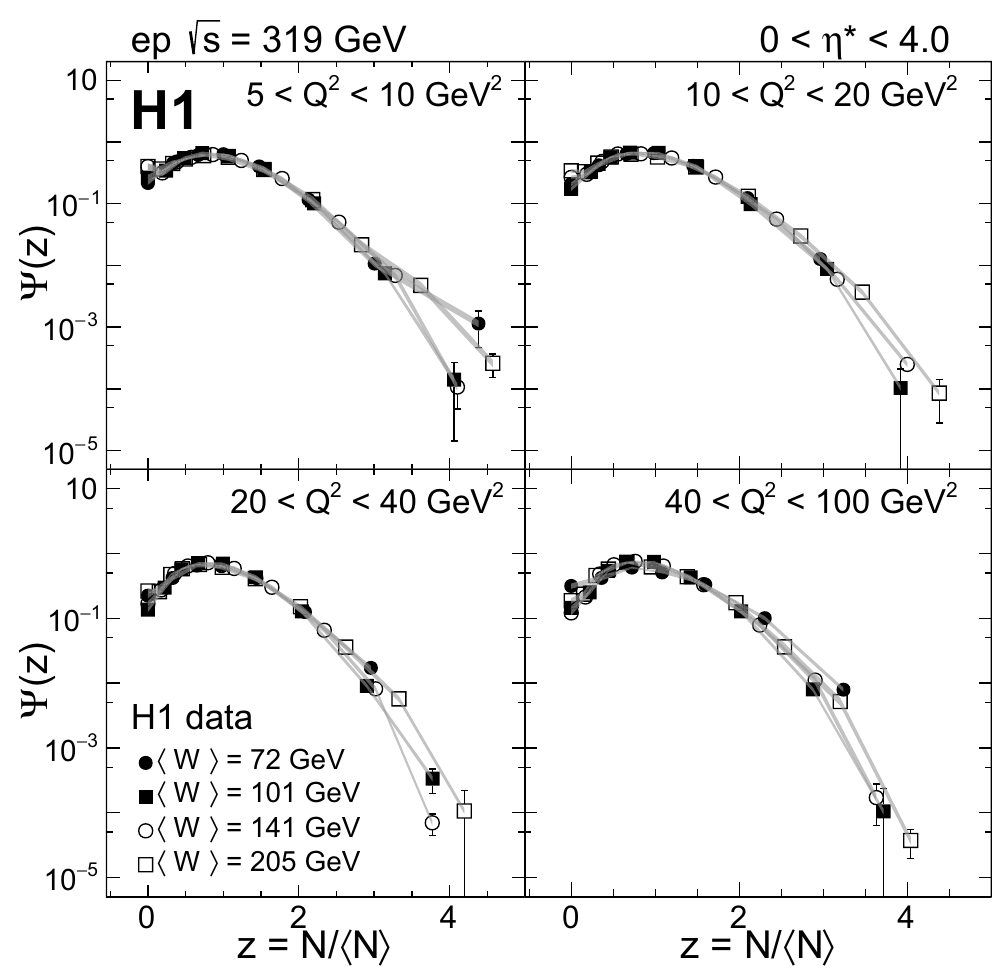
√ Fig. 10 KNO function (cid:8)( z ) as a function of z measured at s = 319GeV in ep collisions in bins of Q 2 with an additional restriction to the current hemisphere 0 < η ∗ < 4. Further phase space restrictions are given in Table 1. The total uncertainty is denoted by the error